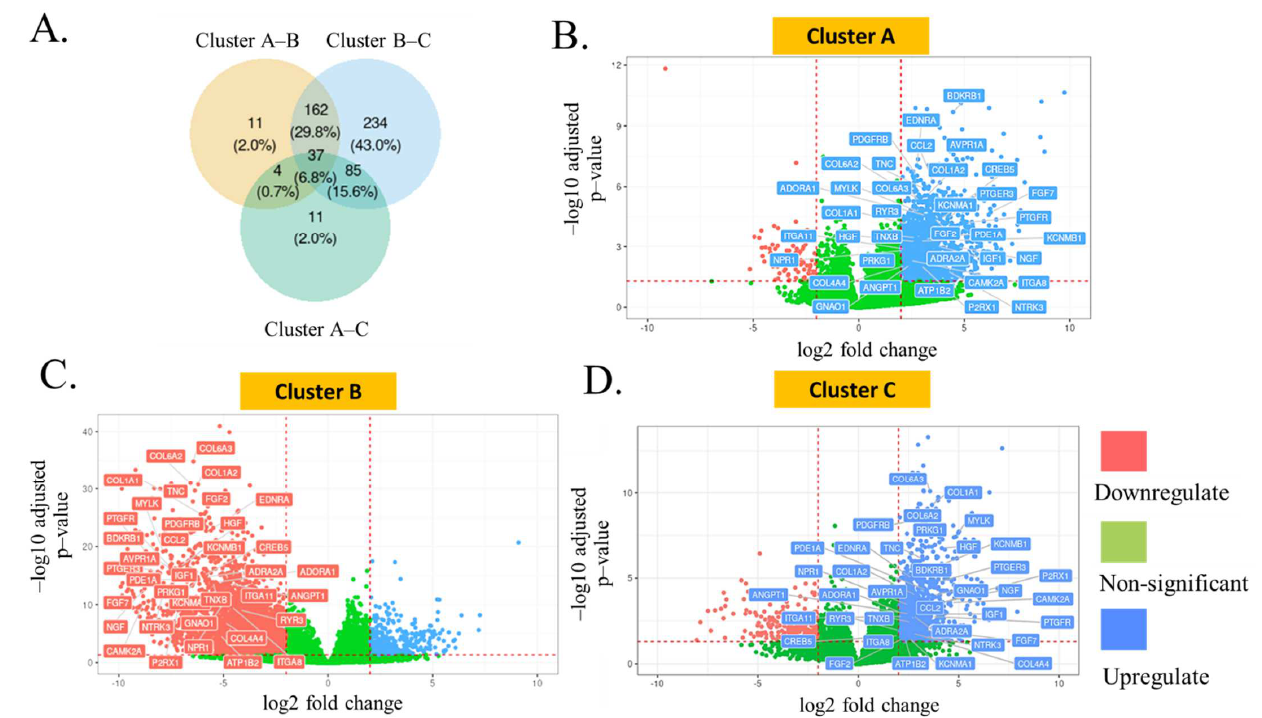
Figure 2. ( A ) The data from differential gene expression (DEG) analysis also revealed the number of genes that expressed differently between two clusters, as displayed in the Venn diagram. The expression levels of each gene are demonstrated as volcano plots for clusters A ( B ), B ( C ), and C ( D ).